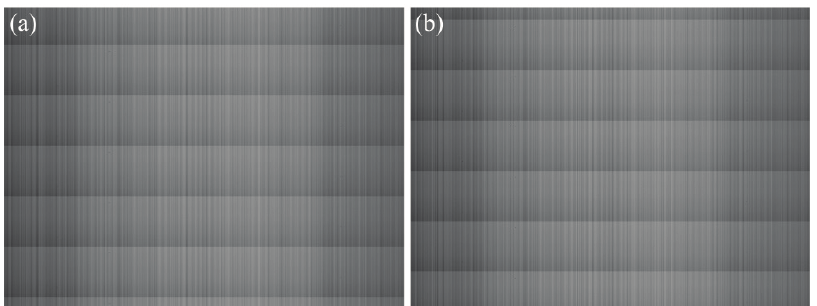
Figure 7. Two different uniform-light images. ( a ) Horizontal stripes in one kind of locations; ( b ) Horizontal stripes in another kind of